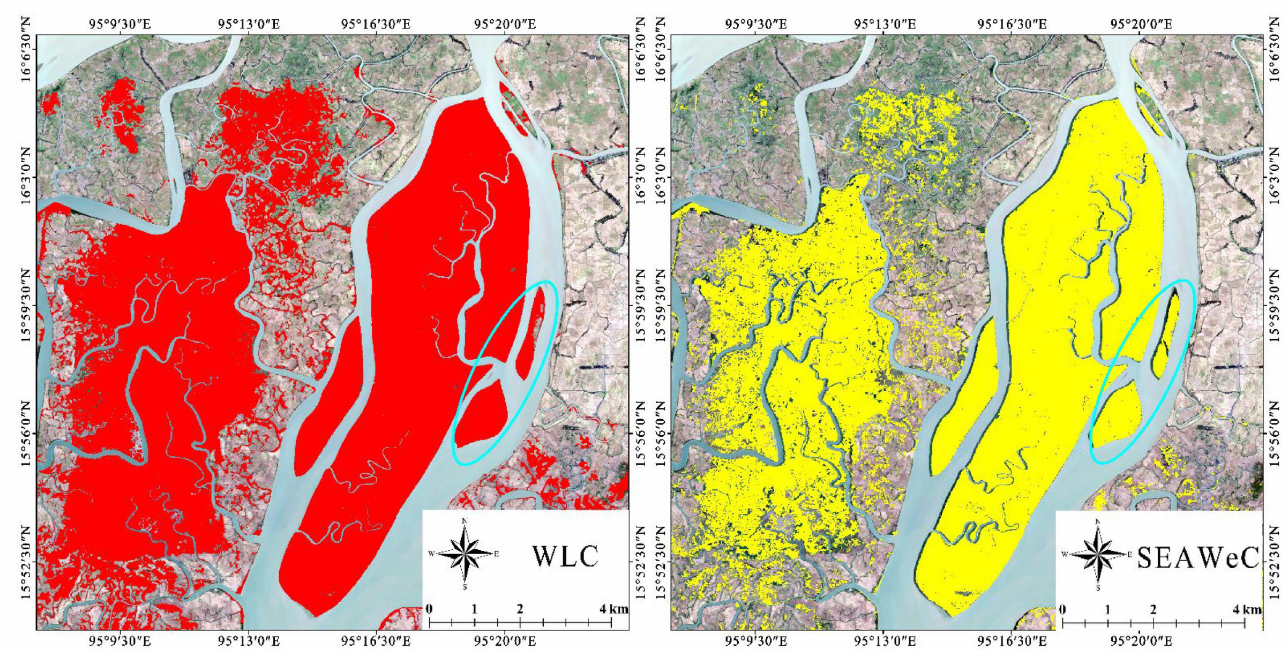
Figure 14. A comparison of the SEAWeC from the GMW product.